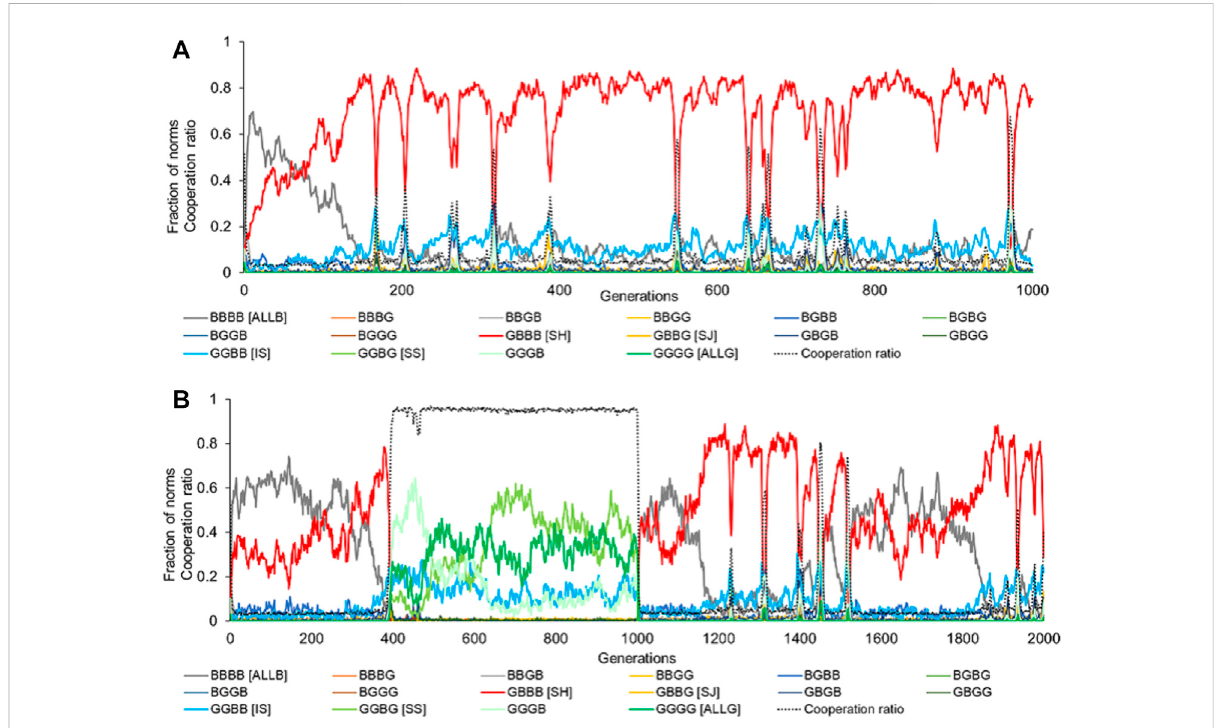
FIGURE 4 Pioneer norms analysis (A) and keystone norms analysis (B) regarding SS. The x -axis shows generations and the y -axis shows the fraction of norms and cooperation ratio. In pioneer norms analysis, SS is knocked out at 0 generations and in keystone norms analysis, SS is knocked out at 1,000 generations. When SS is knocked out in both pioneer norms analysis and keystone norms analysis, the cooperative state is not